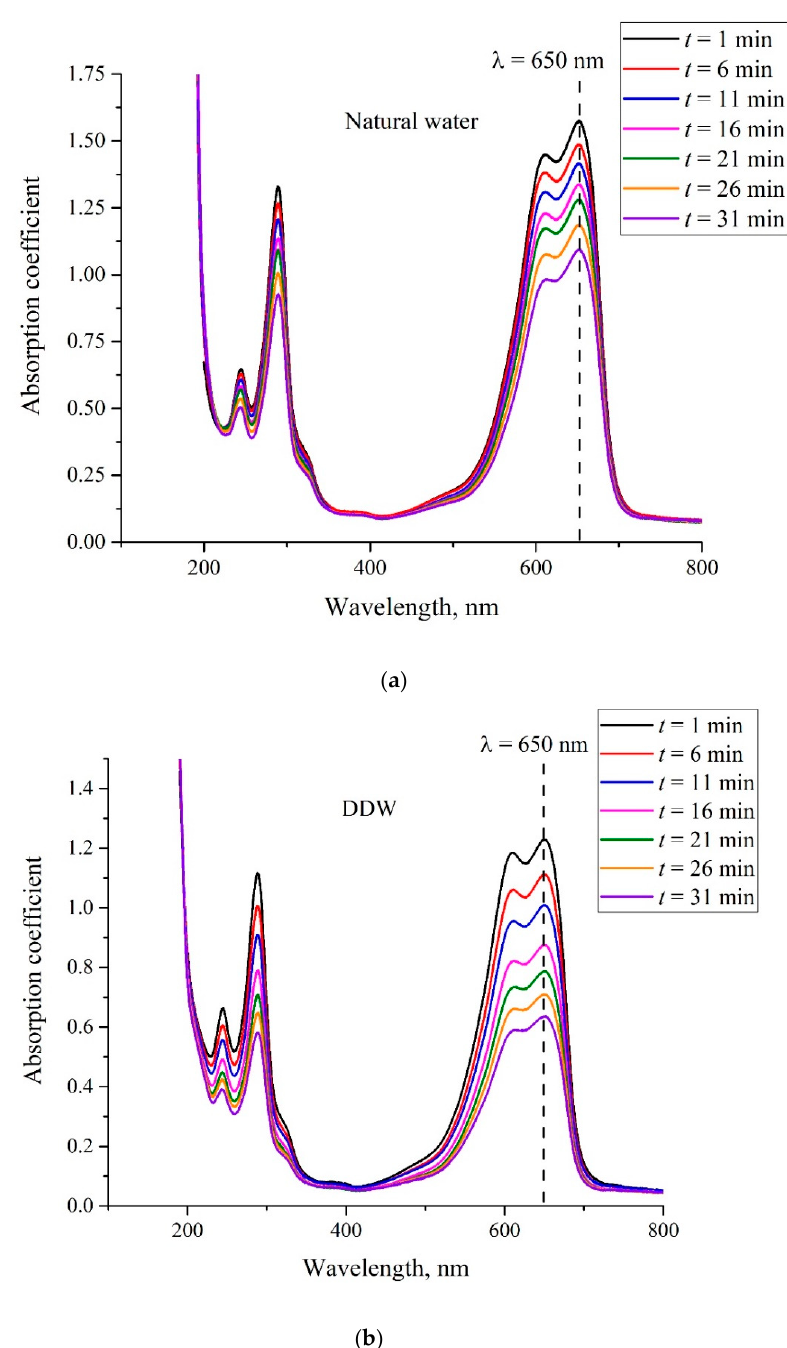
Figure 5. Absorption spectrum of the MB solution with concentration 0.015 mg/mL. The inset shows the time of soaking t . Panel ( a )—the MB solution is based on natural water. Panel ( b )—the MB solution is based on DDW.